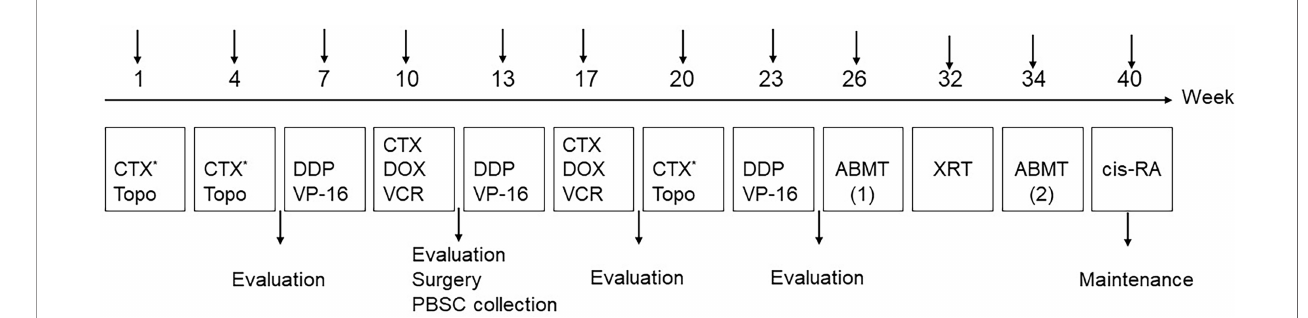
FIGURE 2 | Treatment schedule. PBSC, peripheral blood stem cells; XRT, external beam radiotherapy; 13-cis-RA: cis-retinoic acid.